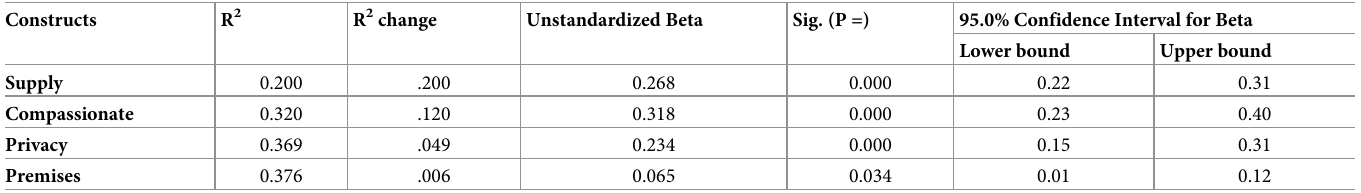
Table 5. Regression estimate (stepwise linear regression) showing relative contribution of satisfaction dimensions in overall satisfaction, December 2020.